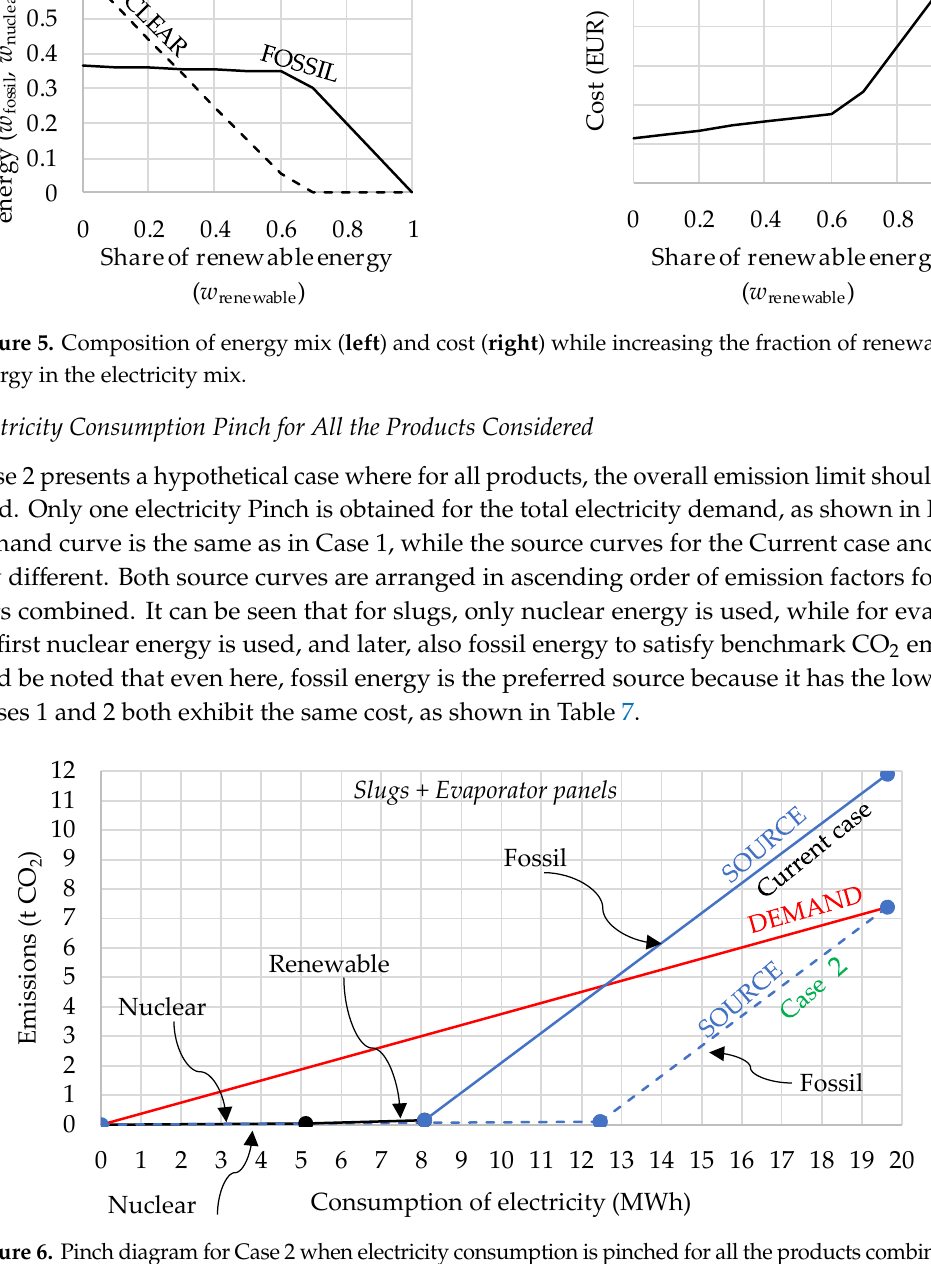
Figure 6. Pinch diagram for Case 2 when electricity consumption is pinched for all the products combined.